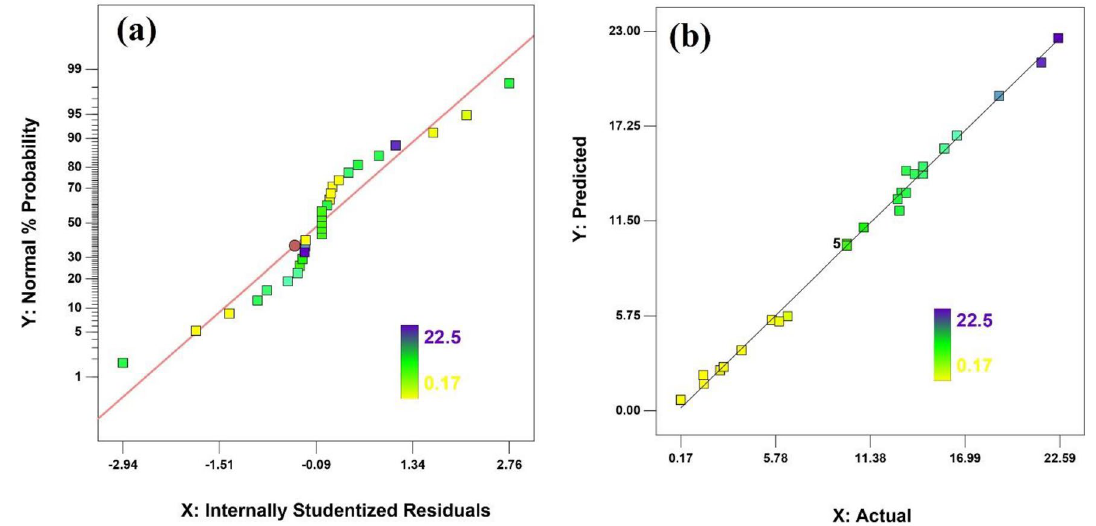
Figure 1. ( a ) Normal plot distributions of the residuals, ( b ) Predicted versus